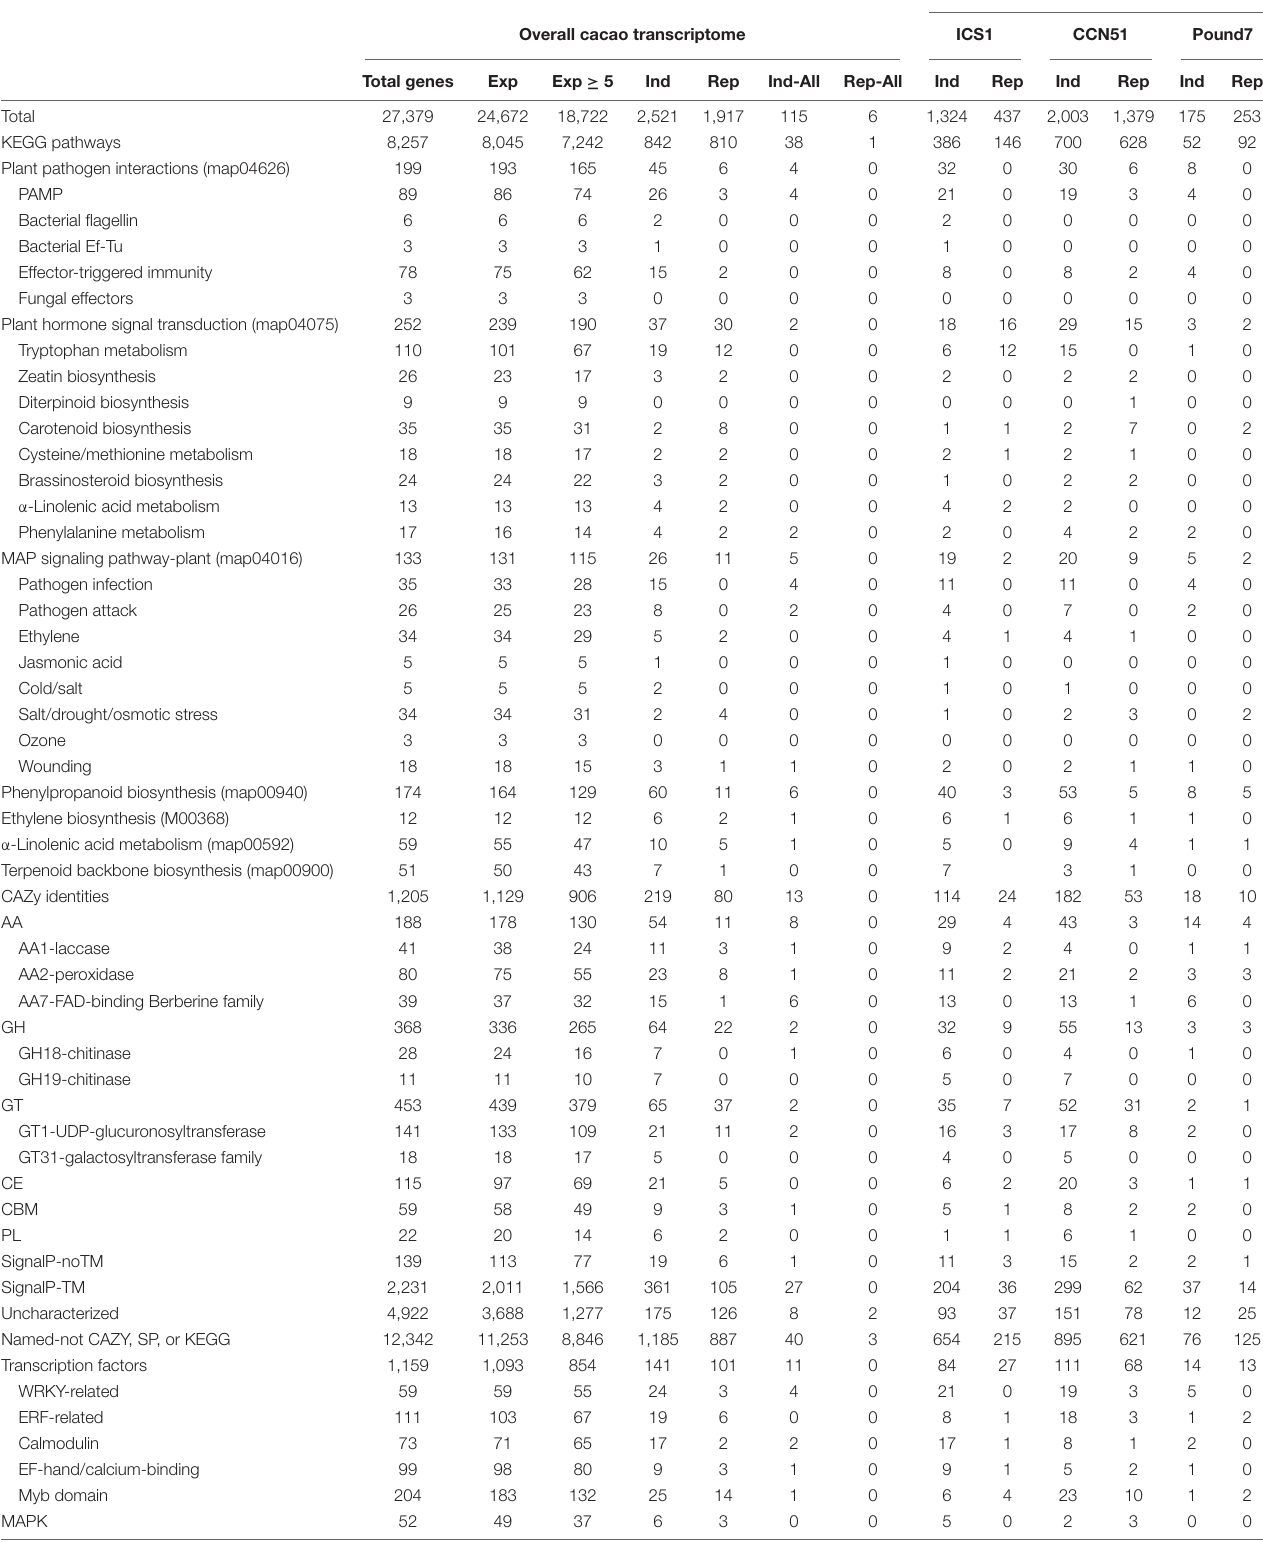
TABLE 1 | Summary analysis of cacao transcriptome and responses of clones ICS1, CCN51, and Pound7 to Phytophthora palmivora 24 h post inoculation.